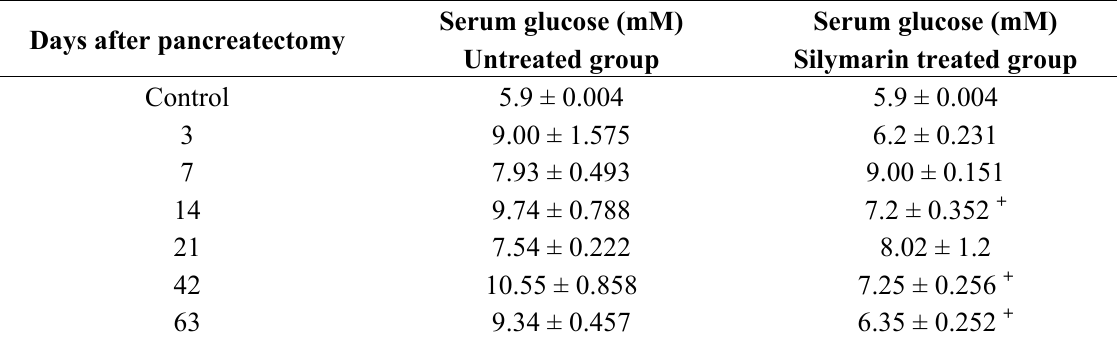
Table 2. Serum glucose levels in experimental